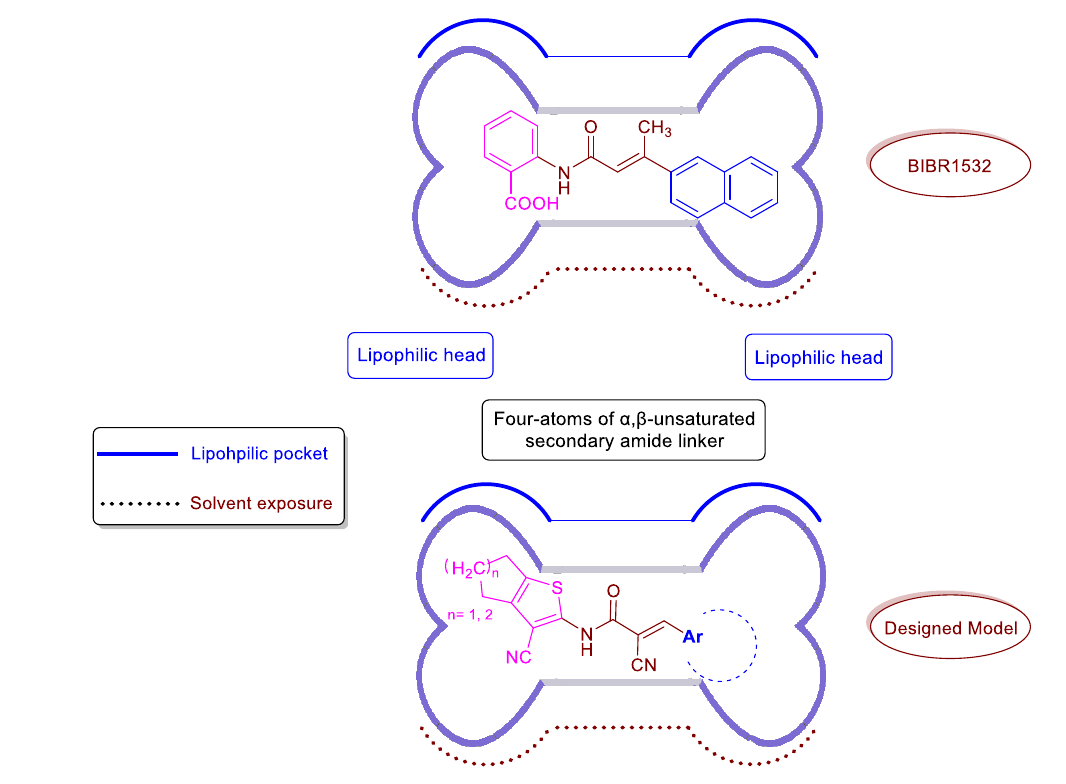
Figure 2. Rational design of our target compounds relying on the dog-bone-shaped structure of BIBR1532 .